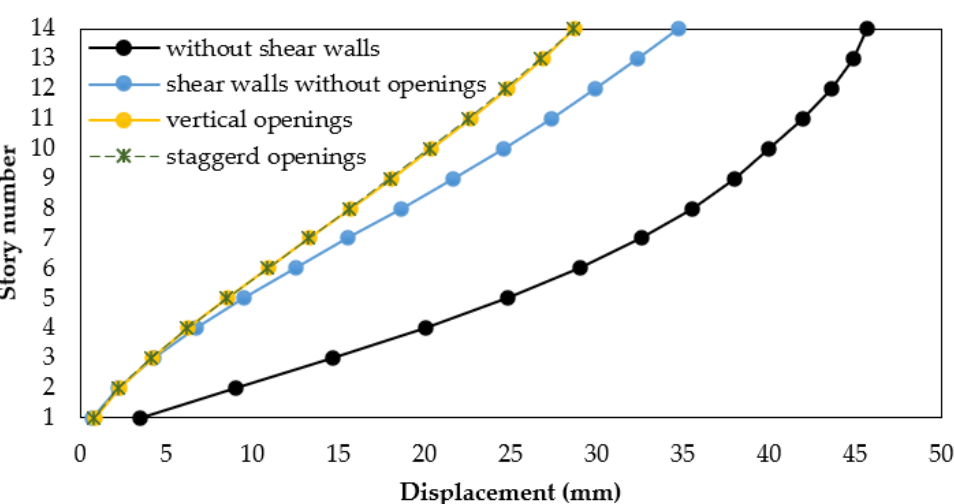
Figure 11. Story displacement of the models, time history analysis, X-direction.